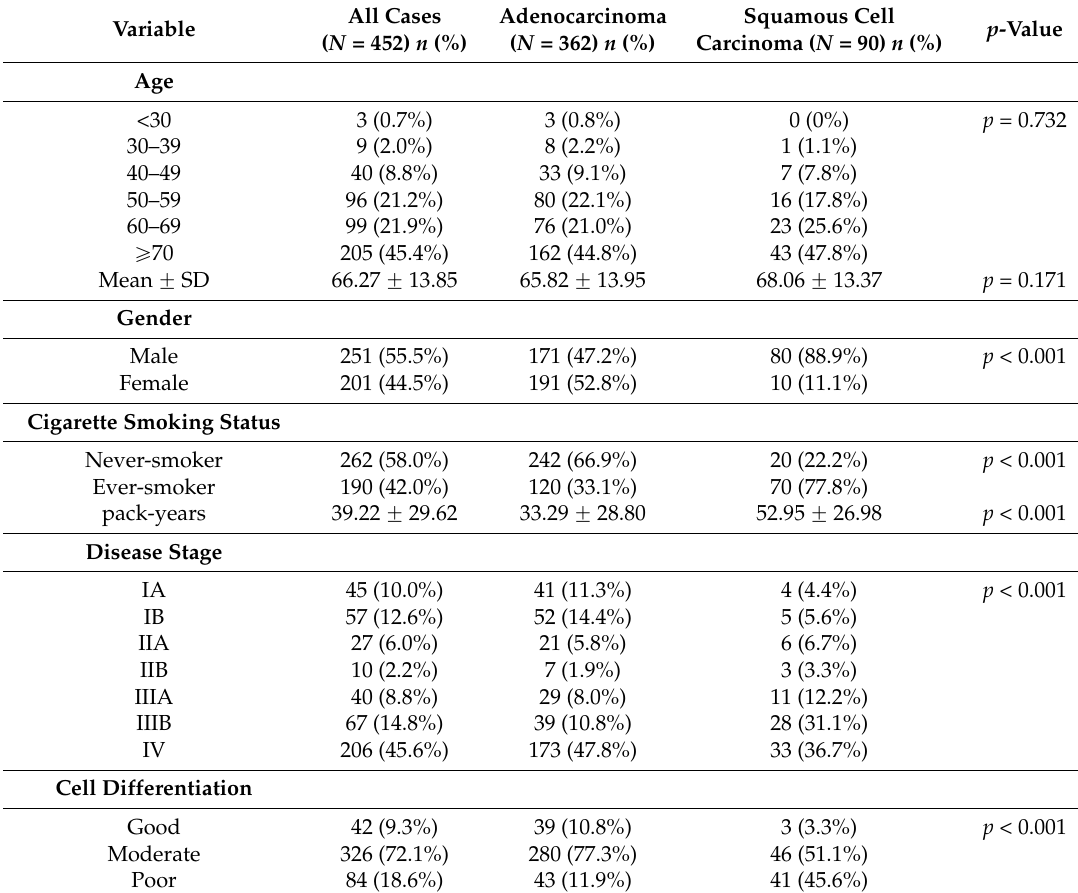
Table 1. Demographics and clinical characteristics of 452 patients with lung adenocarcinoma and lung squamous cell